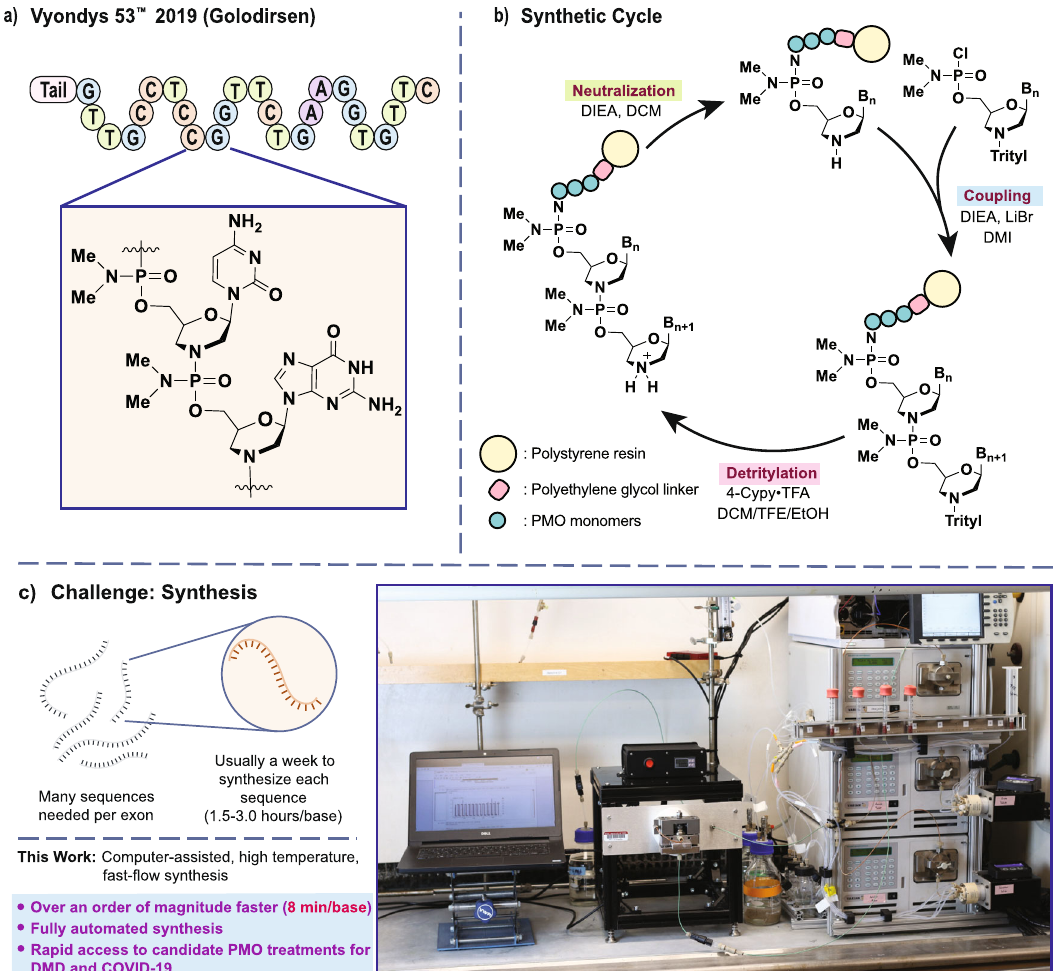
Fig. 1 Automated fast- fl ow technology can produce on-demand customized PMO sequences. a The structure of PMO drug Golodirsen is shown. b Each nucleotide is incorporated as a trityl-protected phosphoramido chloridate in 1,3-dimethyl-2-imidazolidinone (DMI). Detritylation frees the 3 ′ -terminal amine with the conjugate acid of a non-nucleophilic heterocycle, typically 4-cyanopyridine in dichloromethane – tri fl uoroethanol (DCM/TFE) mixtures. Neutralization of the 3 ′ -amine prepares the chain for the next coupling reaction using tertiary amines in DCM/isopropanol mixtures. c Development of PMO drugs requires testing of many sequences and laborious production of sequential revisions. An automated fast- fl ow synthesizer allows for rapid manufacture of PMO sequences at 90